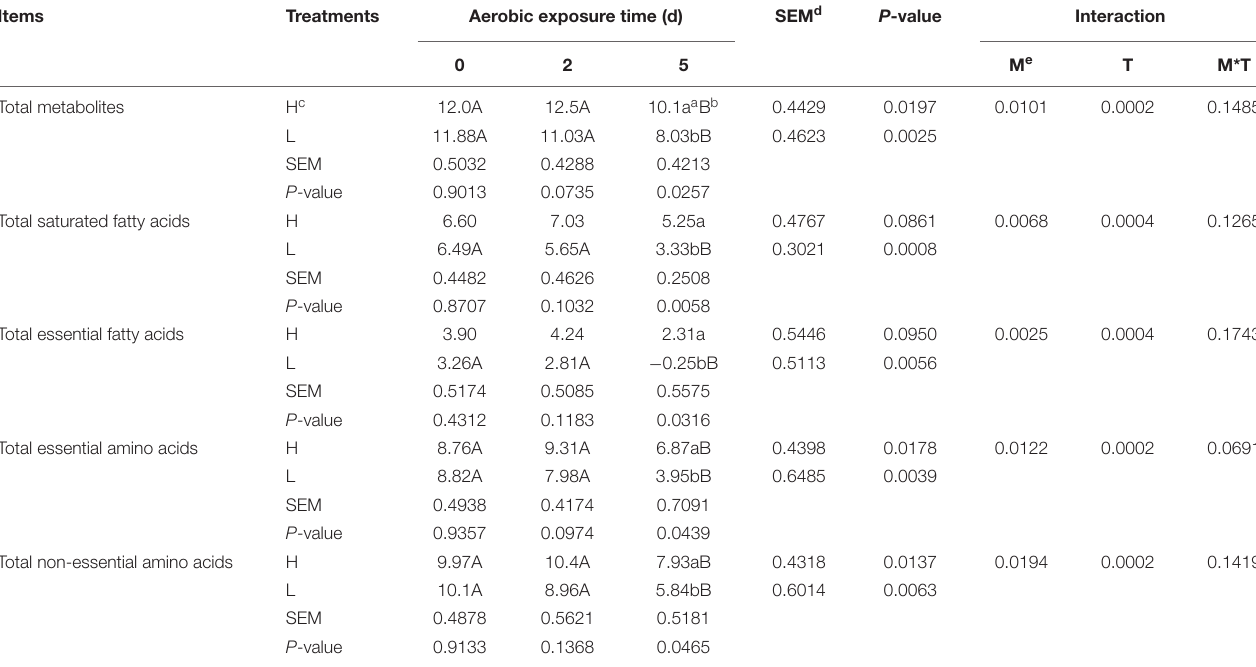
TABLE 3 | Fold-change concentrations (log 2 relative concentrations) of total metabolites, saturated fatty acids, essential fatty acids, essential amino acids and non-essential amino acids in whole-plant corn silages during aerobic exposure.